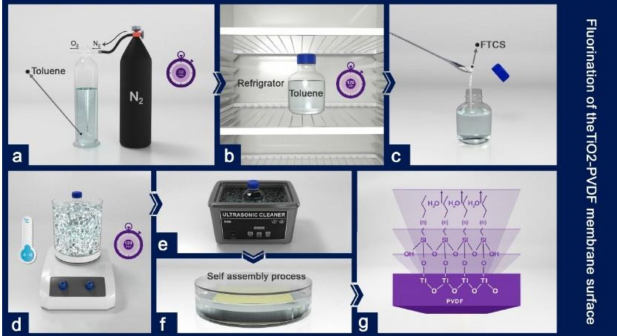
Figure 3. The preparation process of the FTCS–TiO 2 –PVDF membrane: ( a ) purifying toluene using nitrogen; ( b ) reducing the temperature of toluene in a refrigerator; ( c ) mixing toluene with FTCS; ( d ) stirring the mix at a low temperature ( − 5 ◦ C–0 ◦ C); ( e ) using ultrasonication and ice bath to dissolve